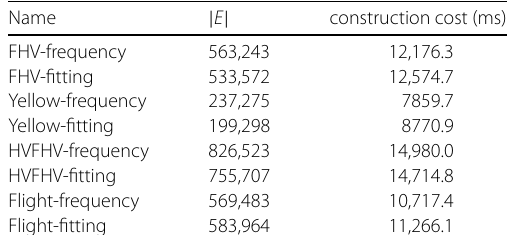
Table 5 Generation time of simulation result. The number of edges in generated networks are close to the cardinality in original real networks. The largest network with 800K edges (HVFHV-frequency) can be generated in no more than 15 seconds